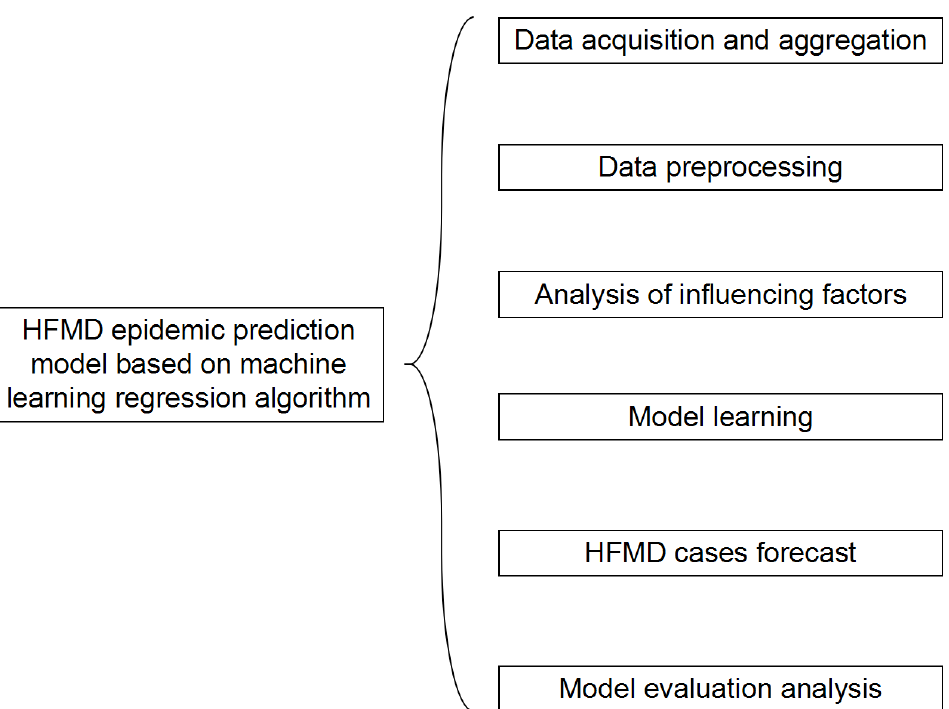
Figure 6. Structure diagram of HFMD epidemic prediction model based on machine learning regres- sion